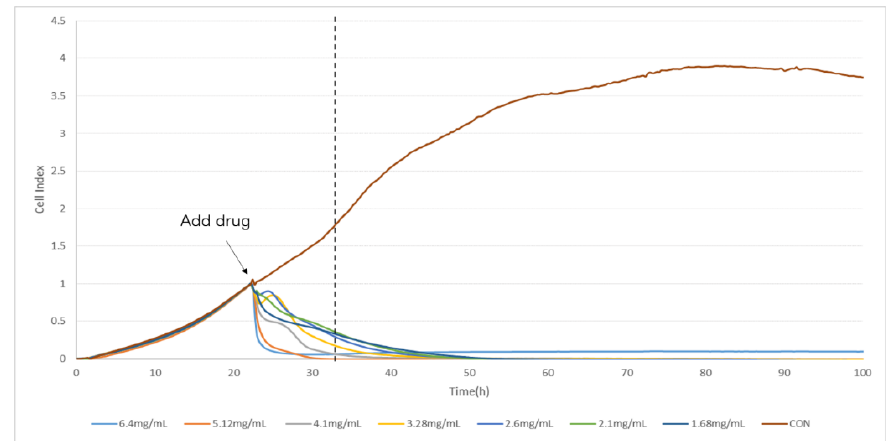
Figure 8. The time/dose-dependent cell response profiles (TCRPs) of the different concentration samples of Anhui Huatuo State pharmaceutical Compound Danshen Tablets (AHSP-CDTs) acting on A549 cells plotted against time with the mean of three experiments. The concentrations are: 6.40 mg/mL (light blue line), 5.12 mg/mL (medium brown line), 4.10 mg/mL (gray line), 3.28 mg/mL (yellow line), 2.60 mg/mL (medium blue line), 2.10 mg/mL (green line), 1.68 (dark blue line), and control (dark brown line).